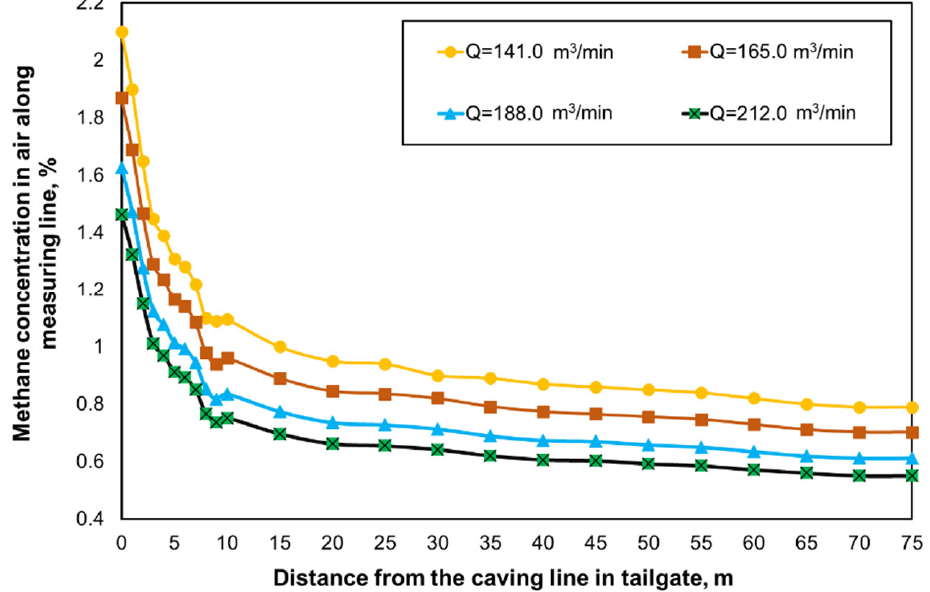
Figure 21. The values of methane concentrations along the measurement line (marked in Figure 3) for the analysed capacities of the air stream supplied through the air duct.